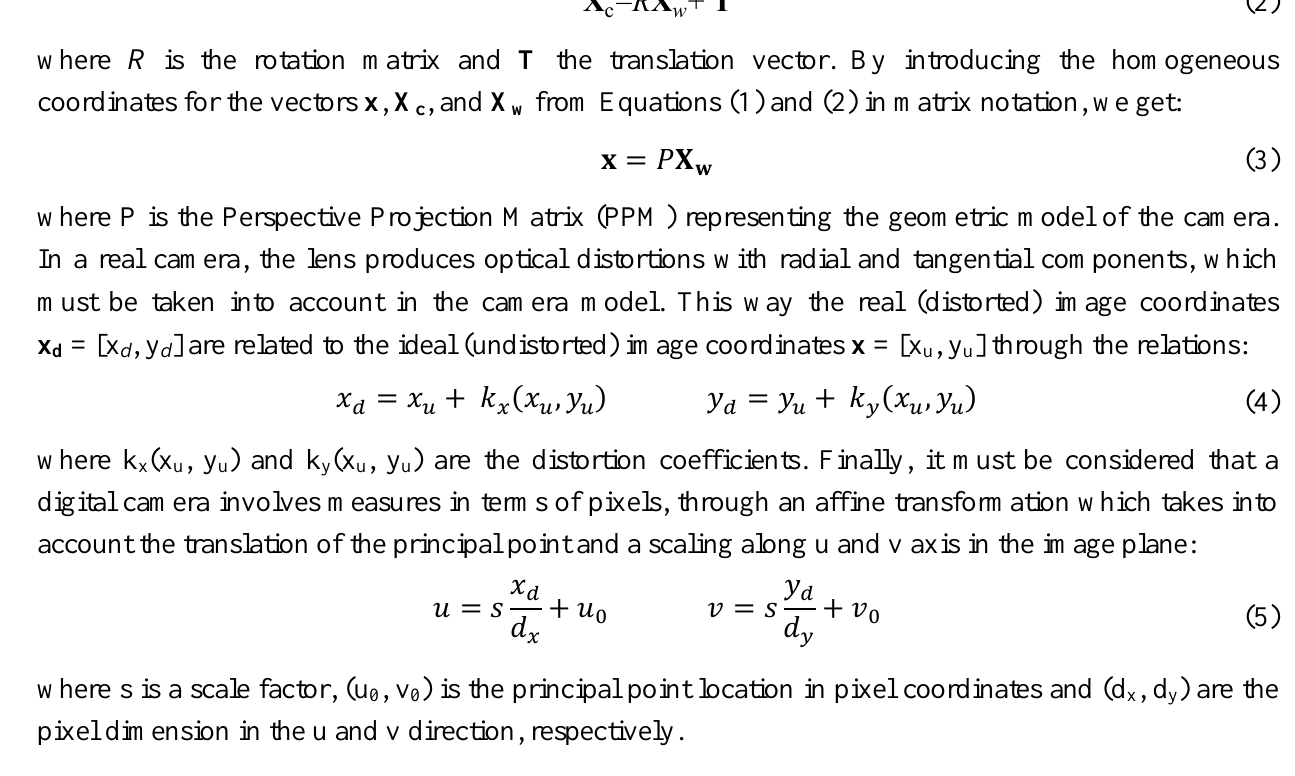
, y ) of a 3D point w is the u v and the image plane I at a c